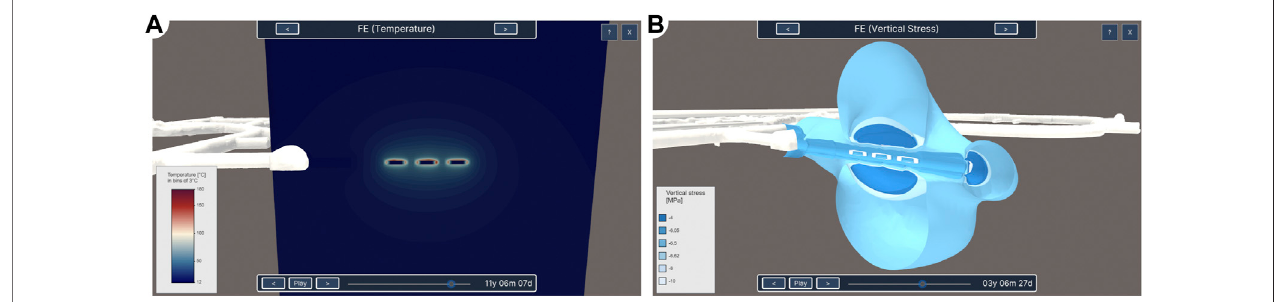
FIGURE 10 | The two visualisation techniques for simulation results in the scope of the FE experiment (A) the modelled temperature as discrete bins of 3 ° C on a clipped volume and (B) the modelled vertical stress as six contour surfaces.